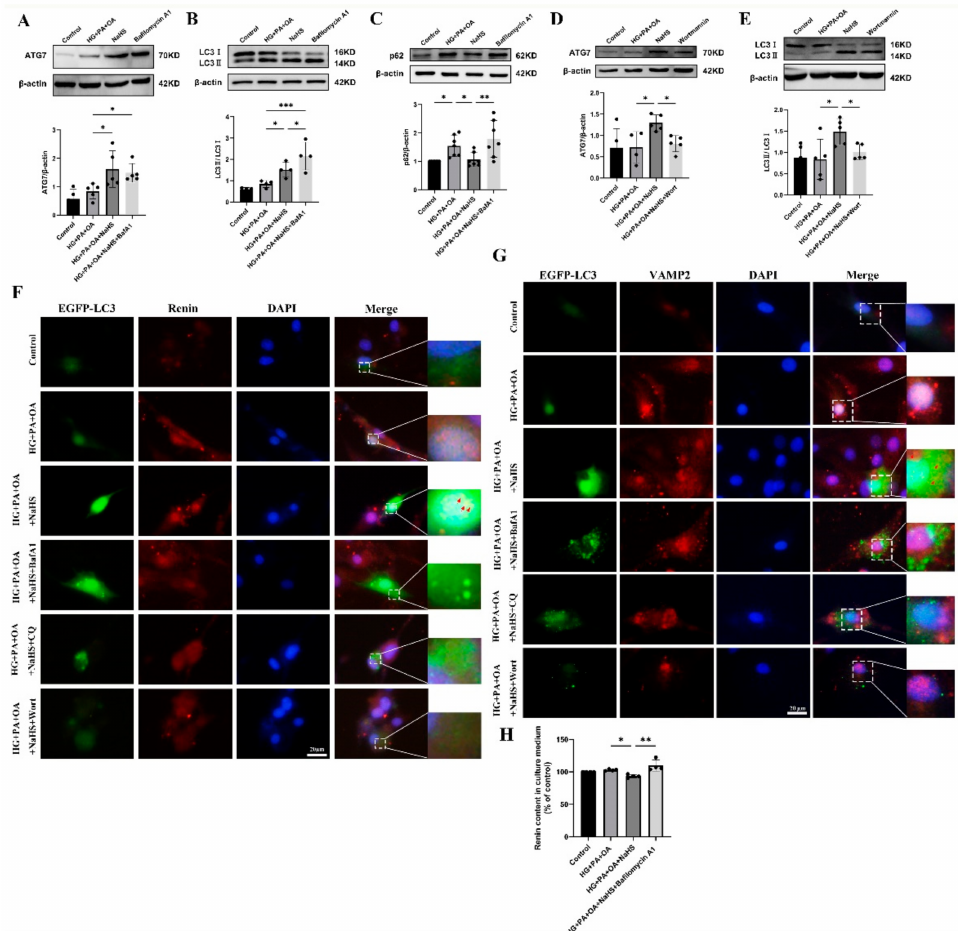
Figure 6. Exogenous H 2 S promoted renin consumption through activation of autophagy. ( A – E ) The expression levels of ATG7, LC3II/I and p62 were detected by Western blotting after treatment with bafilomycin A1 (100 nM) or wortmannin (1 µ M) ( n = 4–7). ( F , G ) The colocalization of renin-containing granules with autophagosomes in JG cells detected by immunofluorescence staining after transfection with EGFP-LC3 plasmid. Scale bar = 20 µ m, ( H ) After treatment with an autophagy inhibitor, the renin content in the cell culture medium of JG cells was detected using ELISA kits. * p < 0.05, ** p < 0.01, *** p < 0.001. BafA1, bafilomycin A1. CQ, chloroquine. Wort,